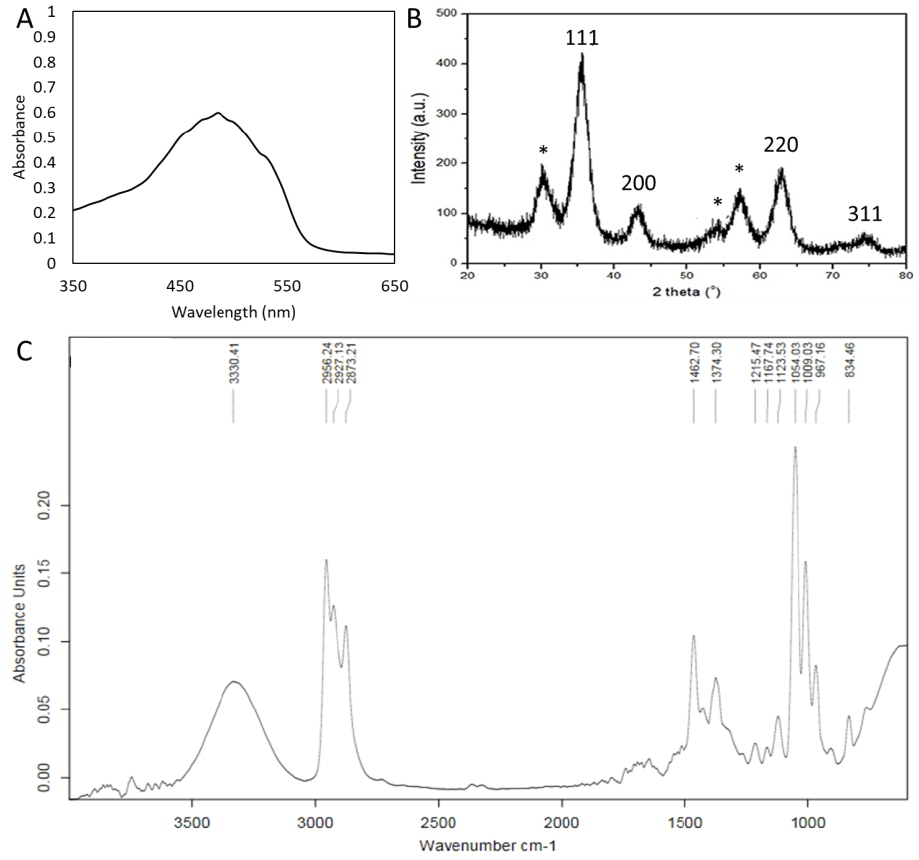
Figure 2. Characterization of GS-AgNP-LEPN. Representative ( A ) spectrum of UV–Visible absorbance in the wavelength range of 350–650 nm, ( B ) XRD spectrum, and ( C ) FT–IR spectrum of GS-AgNP–LEPN.